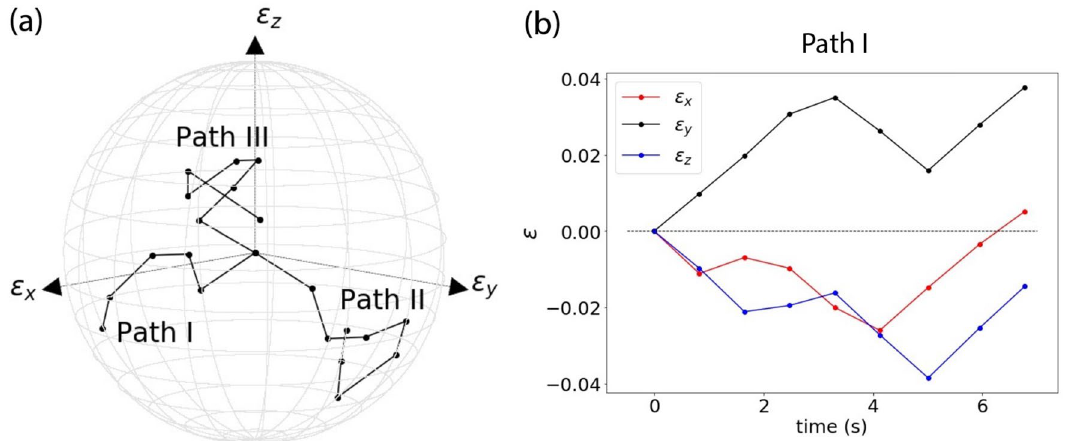
Figure 2. Illustration of the random strain histories imposed on the VEs to generate the training data. (a) Three examples of pseudo-random loading paths. (b) Details of the strain histories associated to Path